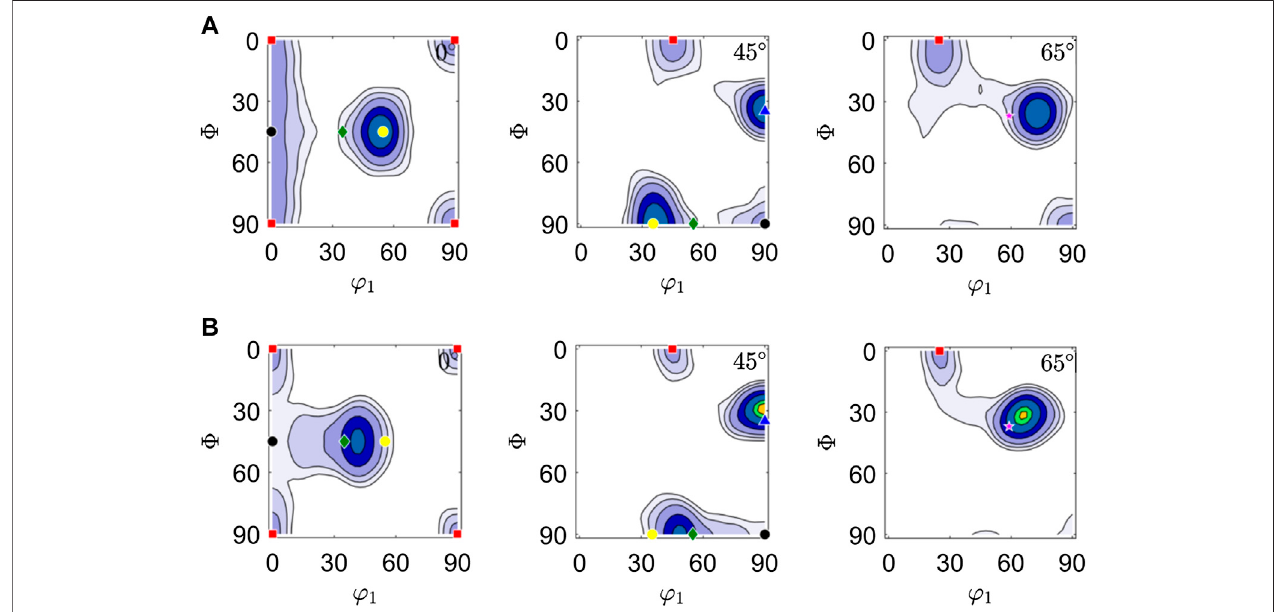
FIGURE 9 | Texture predictions (A) after Von Mises strain of ∼ 1.5, which approximately corresponds to the transition from the uniaxial tensile mode to plane-strain compression mode; (B) at the end of the extrusion process.